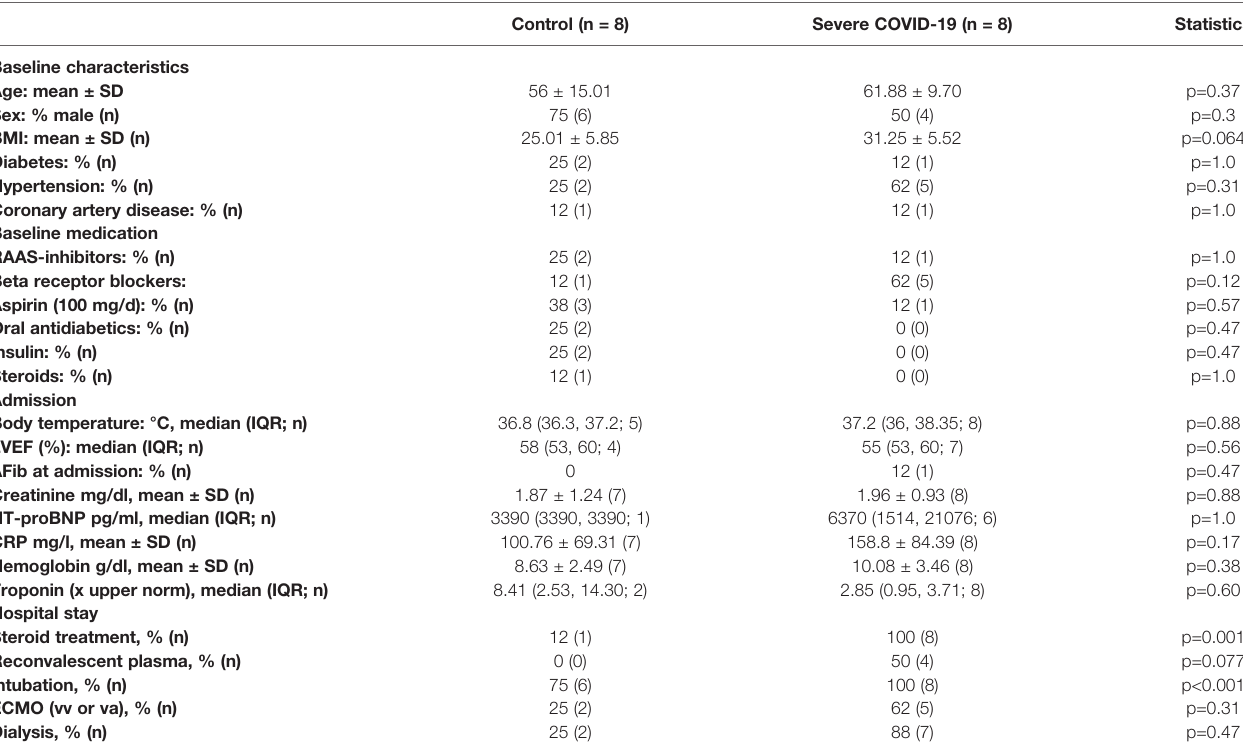
TABLE 2 | Patient characteristics (histological